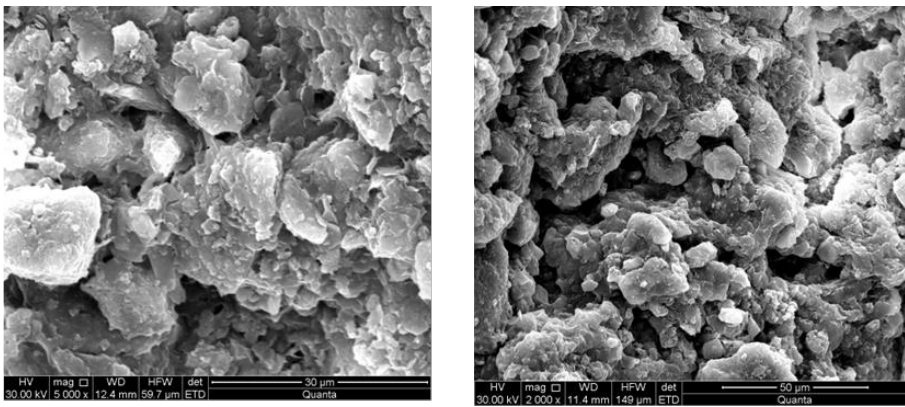
Figure 7. Microstructure of the No.1 fault gouge based on SEM.